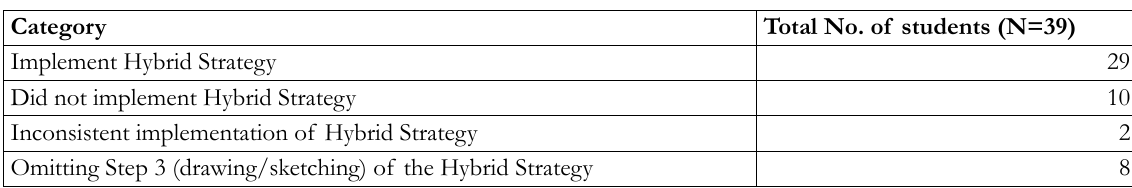
Table 14. Details of students’ implementation of the Hybrid Strategy